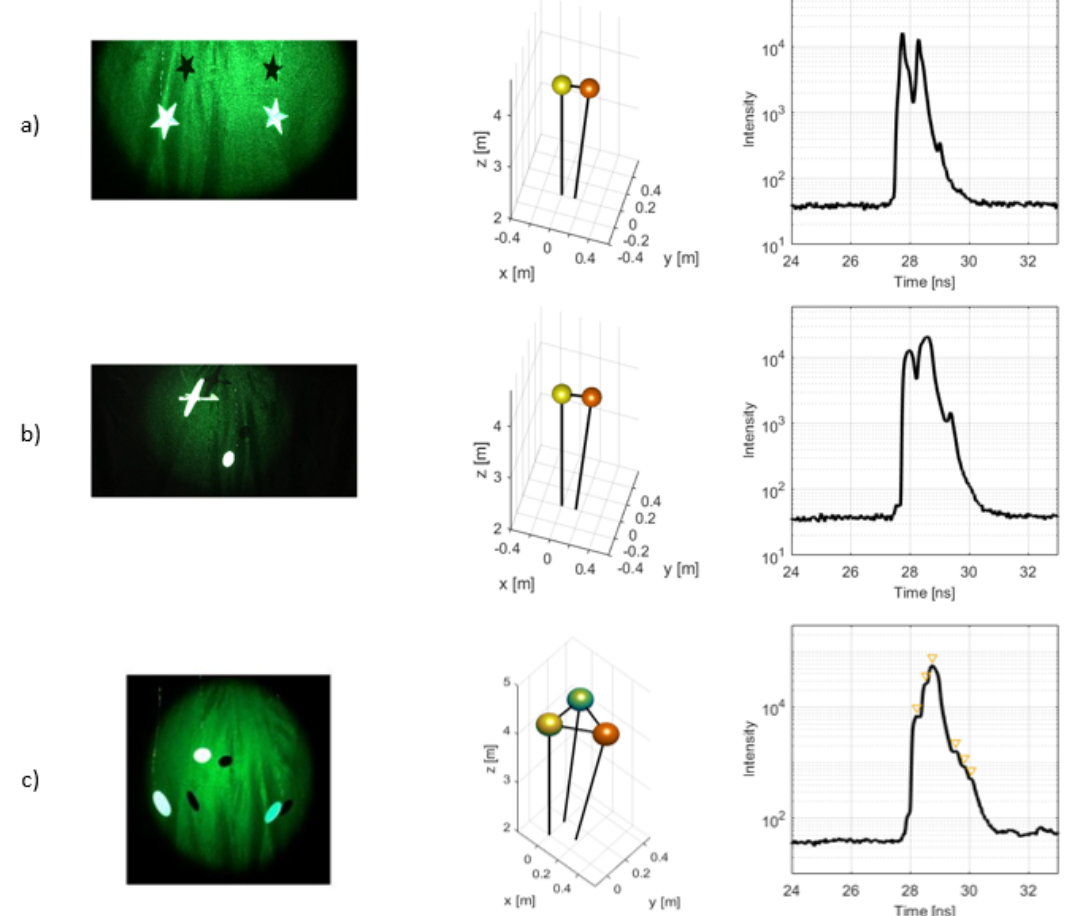
Figure 8. Experiments with different targets. ( a ) Two star targets of size 4 × 4 cm are placed at distance 30 cm from each other. Stars are made of wood and surface color is brown. ( b ) Circular patch and a plane are placed at distance 30 cm from each other. ( c ) Three circular white patches with 4 cm diameter are placed in the scene. In the time response, we can find six peaks: three first and three s